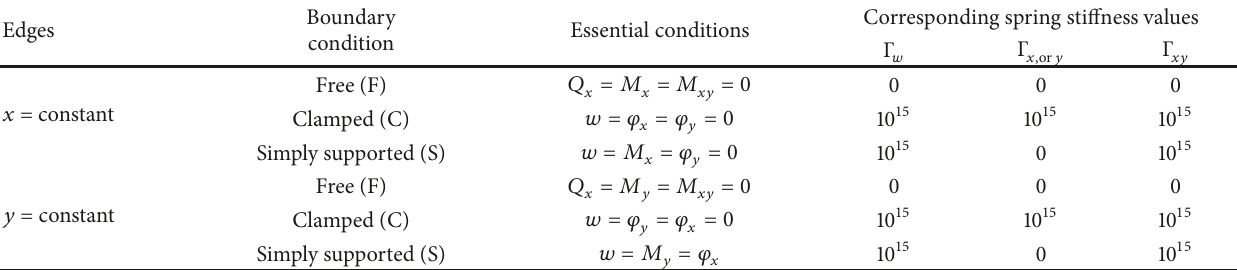
Table 2: The corresponding spring stiffness values for various boundary conditions.